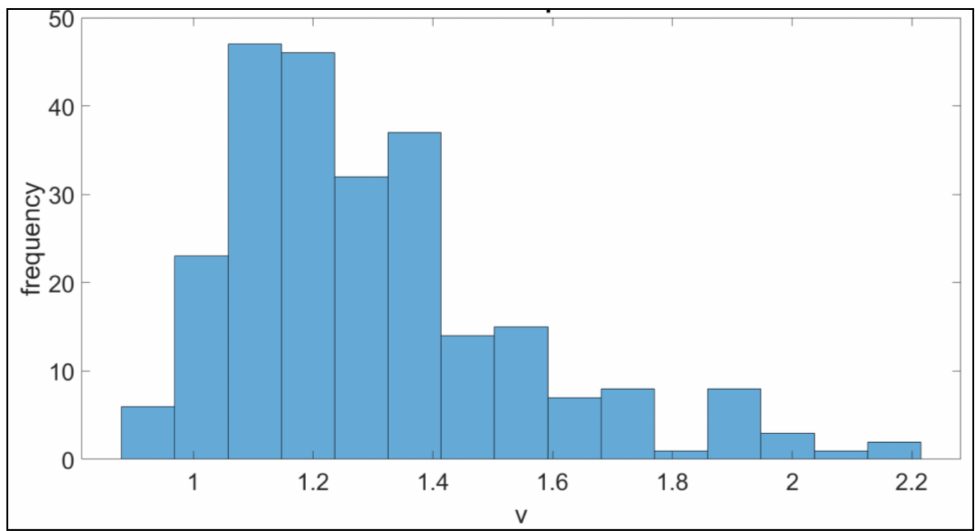
Figure 6. 250 performance indicators of the virtual CMM based the ISO 10360-2 acceptance test.